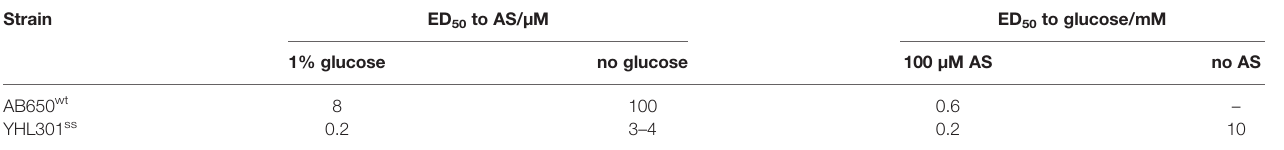
TABLE 3 | ED 50 of A. tumefaciens biosensors to acetosyringone (AS) or glucose. Strain ED 50 to AS/µM